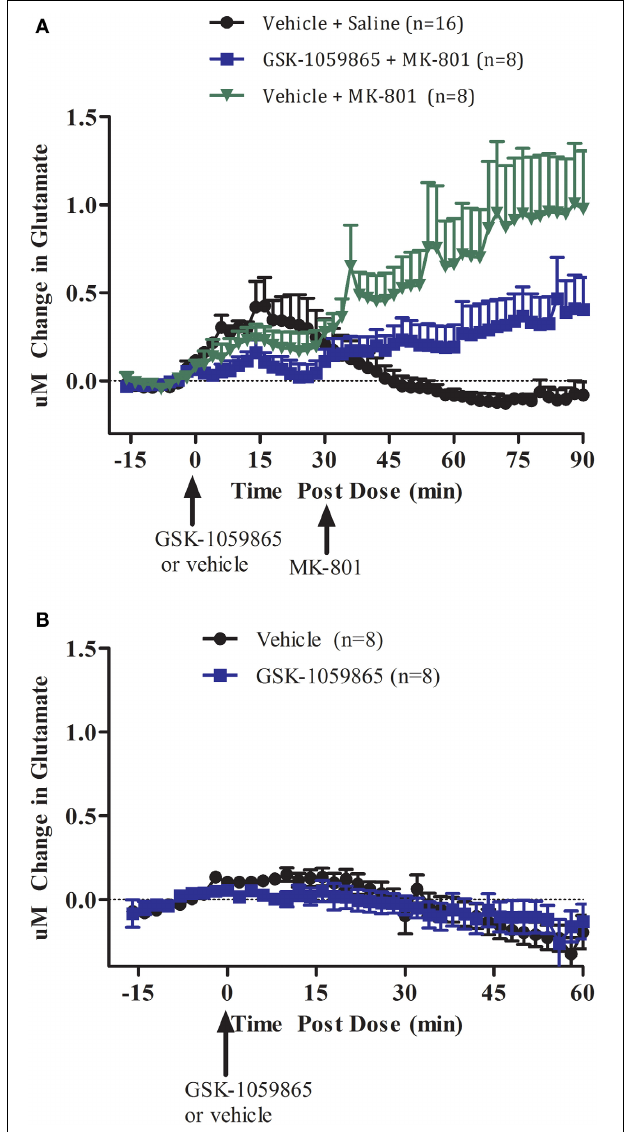
FIGURE 1 | (A) Effect of GSK-1059865 (10mg/kg S.C.) on MK-801 (0.178mg/kg, S.C.) induced glutamate release in the cortex of freely moving wild-type mice (within subject study design). GSK-1059865 was administered at t = 0 and MK-801 was administered at t = 30min. (B) Effect of GSK-1059865 (10mg/kg S.C.) on glutamate release in the cortex of freely moving wild-type mice (across subject study design). GSK-1059865 was administered at t = 0. Real-time measurements of glutamate were conducted before and after compound administration.